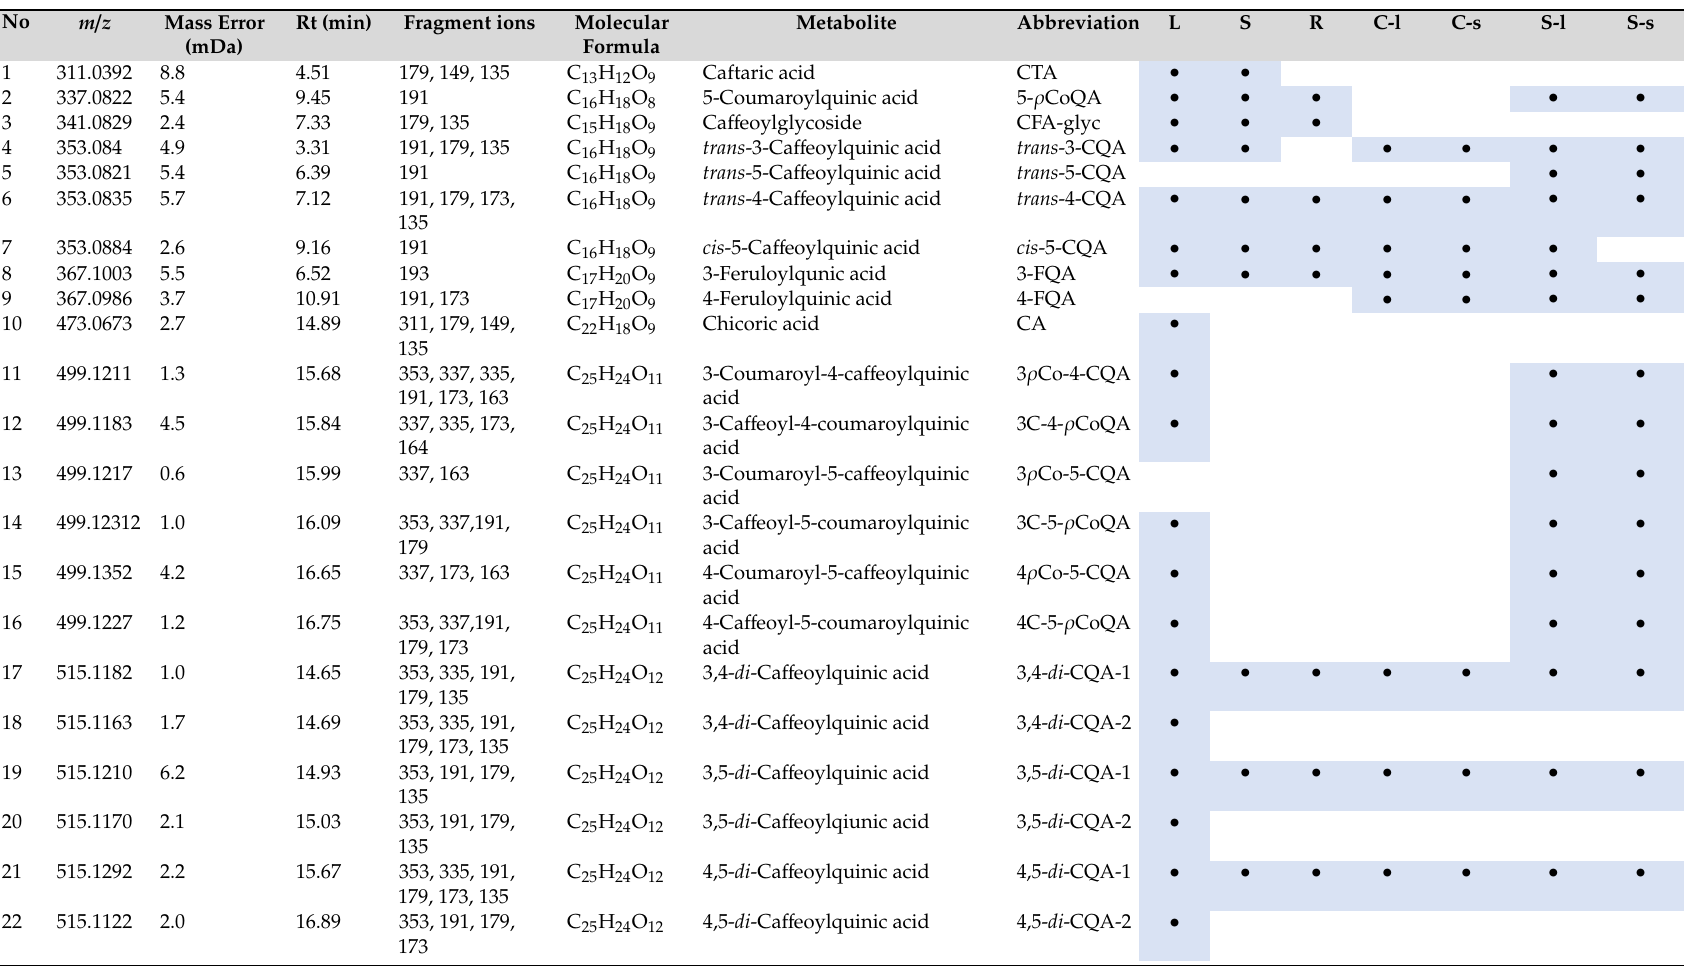
Table 1. Characterization of chlorogenic acids (CGAs) consisting of hydroxycinnamic acid (HCA) derivatives of quinic acid (QA) and tartaric acid from tissues (L-leaves, S-Stems and R-Roots) and from two callus cell lines (C-L and C-S) and two cell suspension lines (S-L and S-S) of Bidens pilosa .